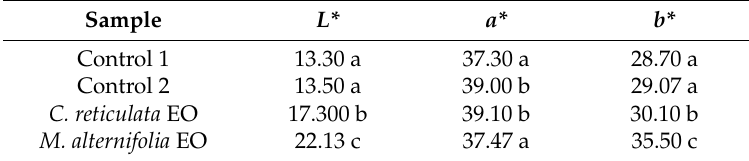
Table 3. Chromatic coordinates of the cherries treated with Citrus reticulata and Melaleuca alternifolia essential oils (EOs).